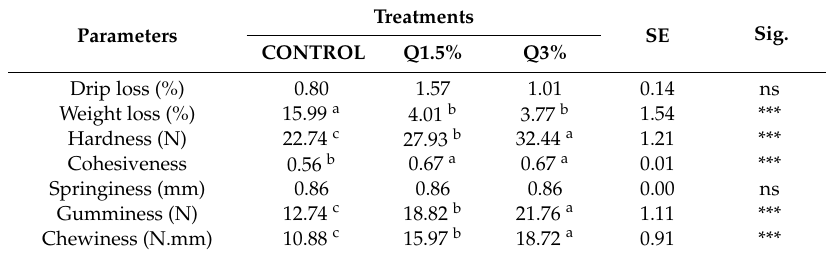
Table 2. E ff ect of the chitosan inclusion on drip loss, water loss by pressure, and texture profile